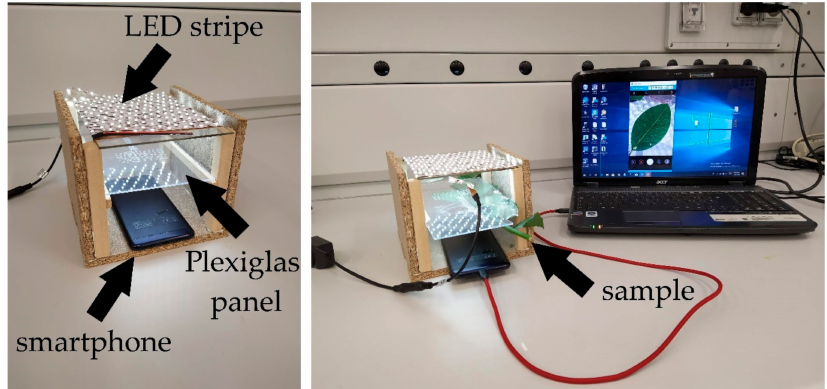
Figure 1. Experimental set-up. For clarity’s sake, only a small twig is shown in the photograph, but experiments were performed on branches longer than 1 m in order to avoid open-vessel artifacts (see Materials and Methods for details).